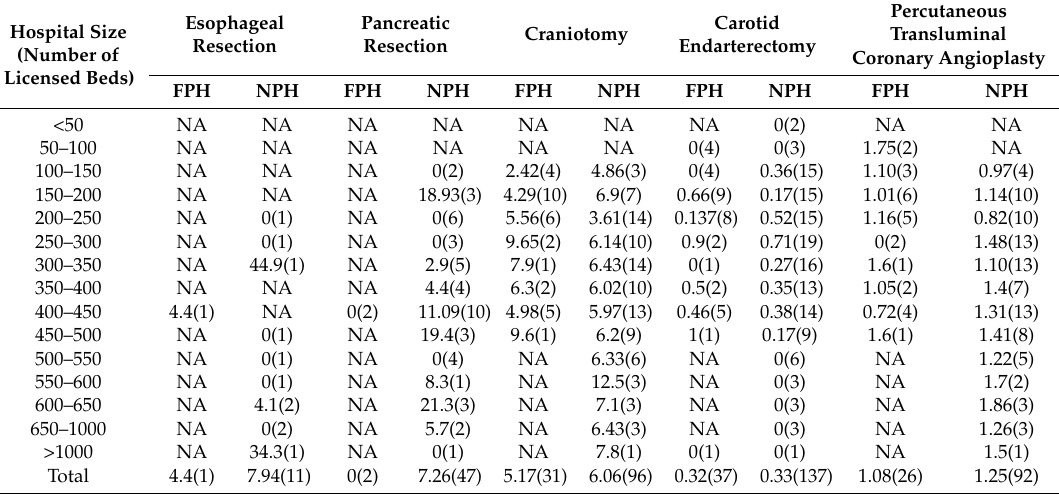
Table 4. Hospital Quality (In-hospital Deaths after Surgery—Risk-adjusted Mortality